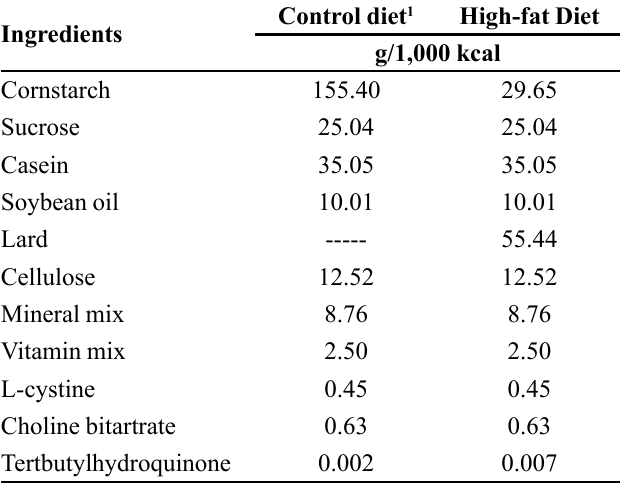
TABLE I – Experimental diet composition